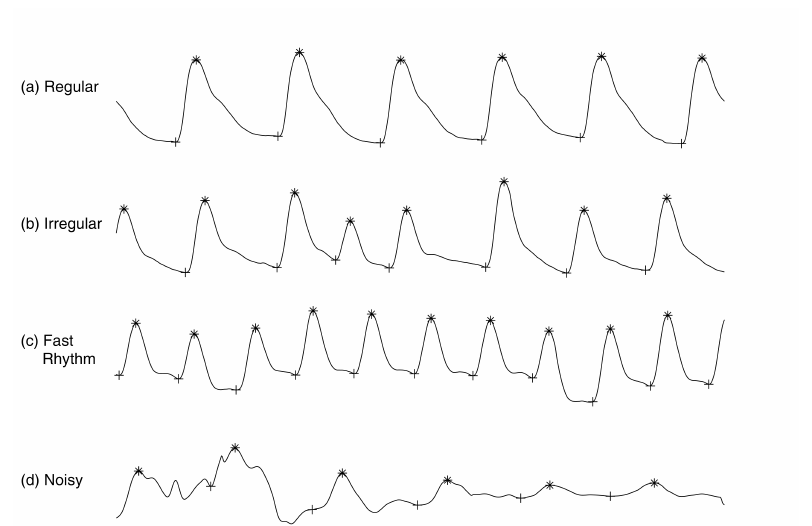
Figure 1. Four types of PPG templates. The regular, irregular, fast-rhythm, and noisy templates are ( a – d ), respectively. The “*” and “+” in ( a – d ) refer to the annotated systolic peak and onset, respectively.